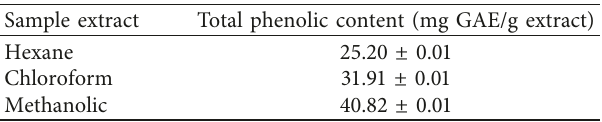
Table 1: Total phenolic content of P. bleo hexane, chloroform, and methanolic